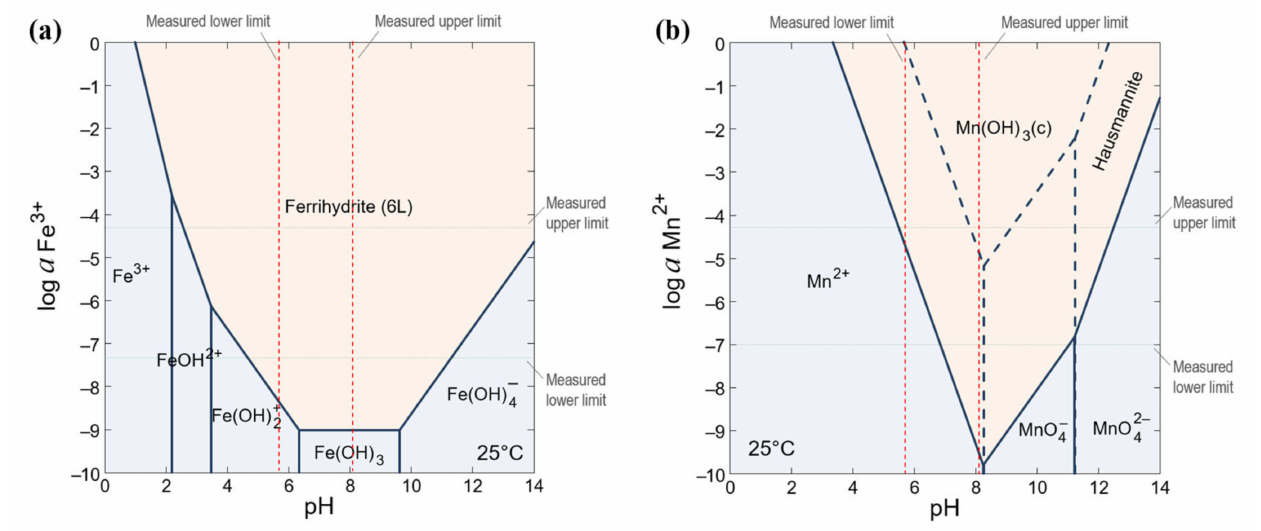
Figure 8. ( a ) Log activity–pH diagram of Fe-H 2 O System created using the Geochemist’s Workbench ® in equilibrium with atmospheric O 2 (Fugacity = 0.2), and ( b ) Log activity–pH diagram of Mn-H 2 O sys- tem created using the Geochemist’s Workbench ® in equilibrium with atmospheric O 2 (Fugacity = 0.2). The dotted and dashed lines represent the maximum and minimum values measured for Mn concentra- tions and pH in surface water on-site,